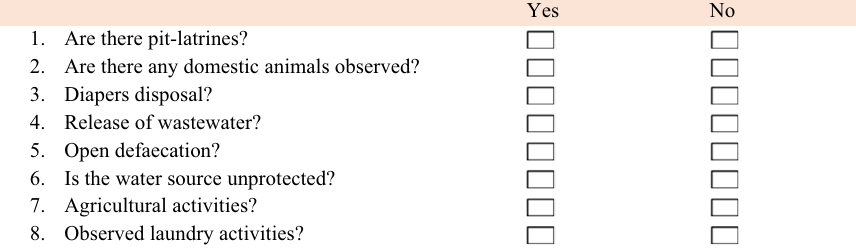
Table 5. Sanitary inspection